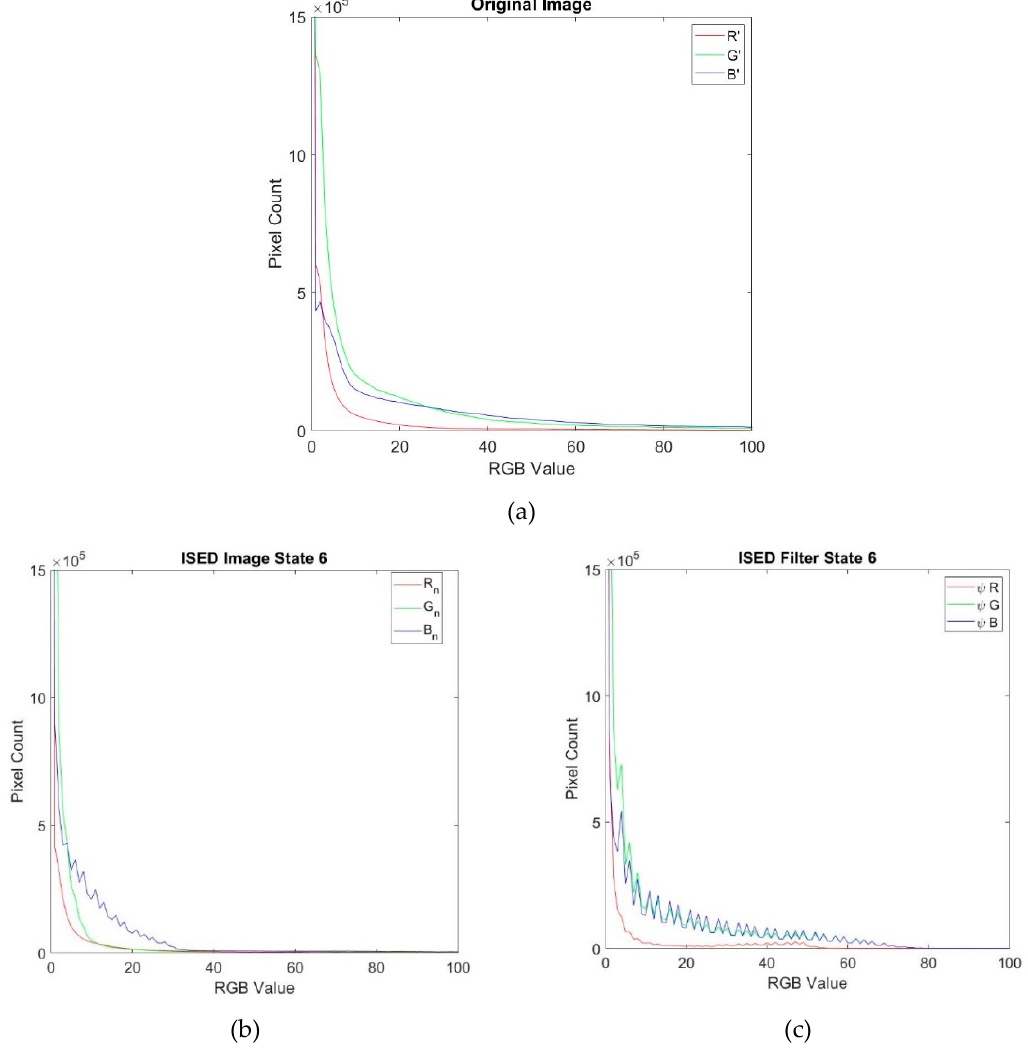
Figure 4. Individual histograms of red (R), green (G), and blue (B) components of the ( a ) original image, ( b ) ISED image of state 6, and ( c ) the ISED filter image of state 6.